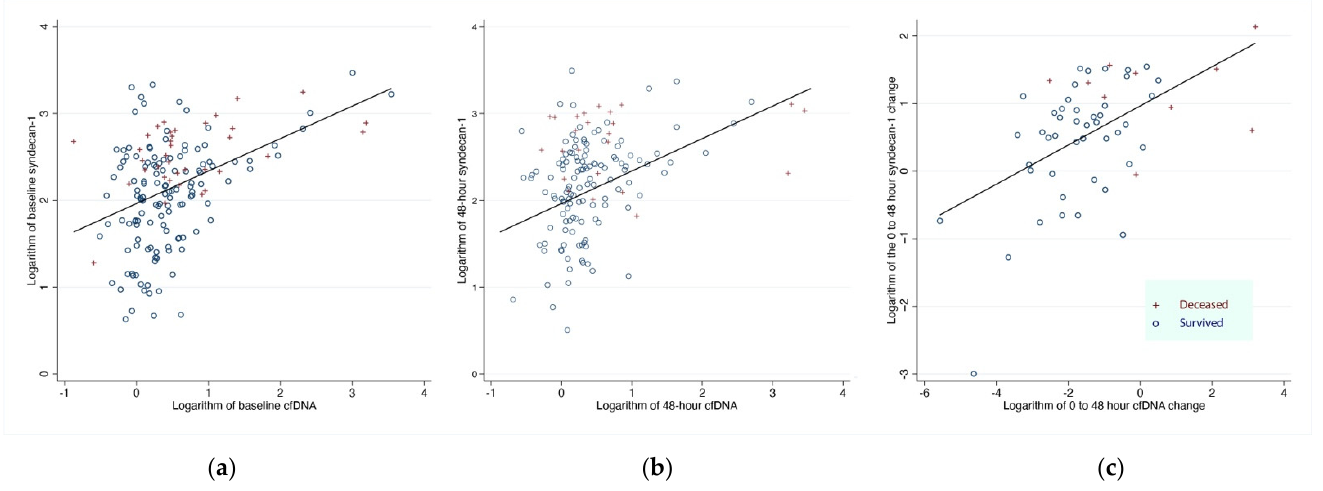
Figure 3. Scatterplot of ( a ) baseline levels and ( b ) 48 h levels and ( c ) 48 h change from baseline, of plasma cfDNA and syndecan-1. The fitted line corresponds to the regression line. Survivors at 7 days are represented with hollow circles, and expired subjects are represented with red crosses (+).